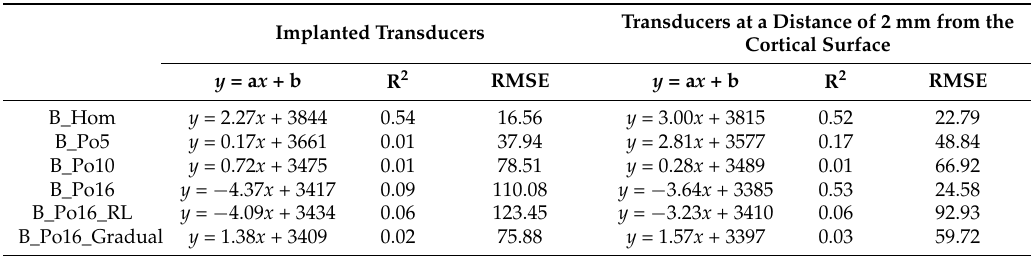
Table 4. Linear fit of the mean FAS velocities derived from all the receiving positions and the excitation frequency 1 MHz.